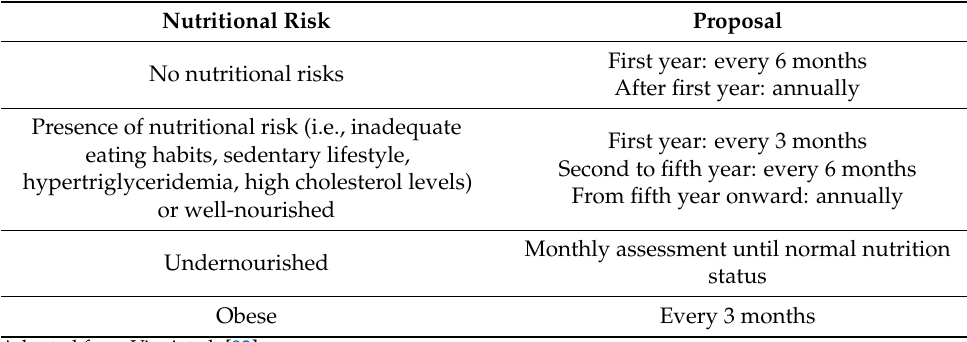
Table 3. Proposed timing of nutritional assessment into survivorship